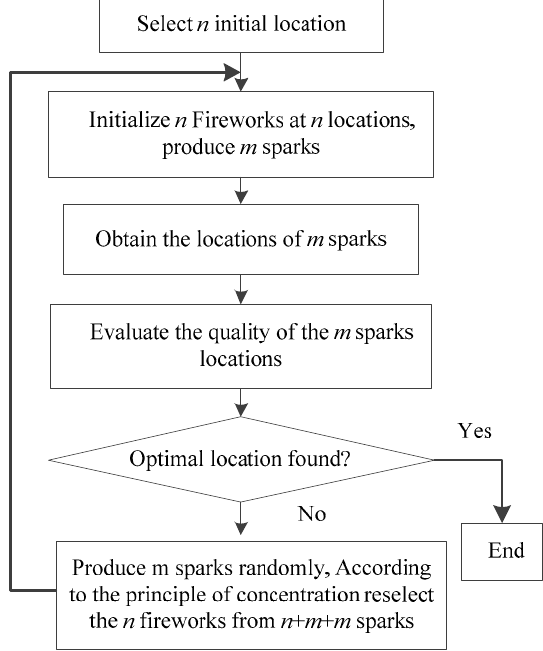
Figure 2. Flowchart of fireworks algorithm operation.